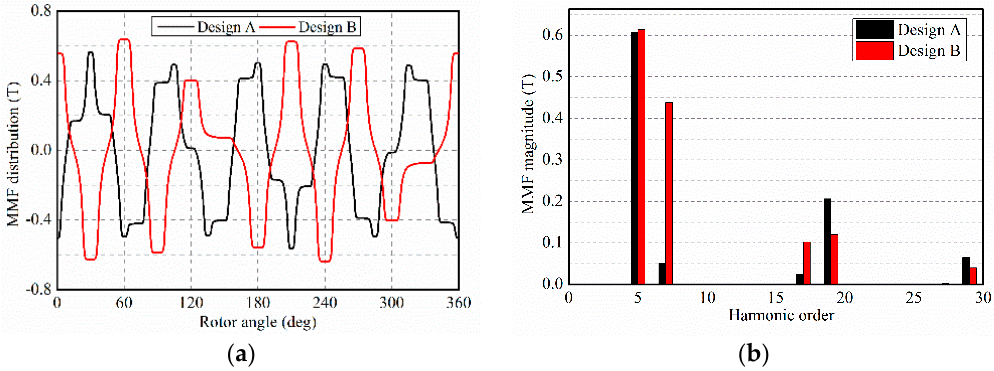
Figure 8. MMF distributions for Design A and B: ( a ) MMF distributions; ( b ) Harmonic spectra.